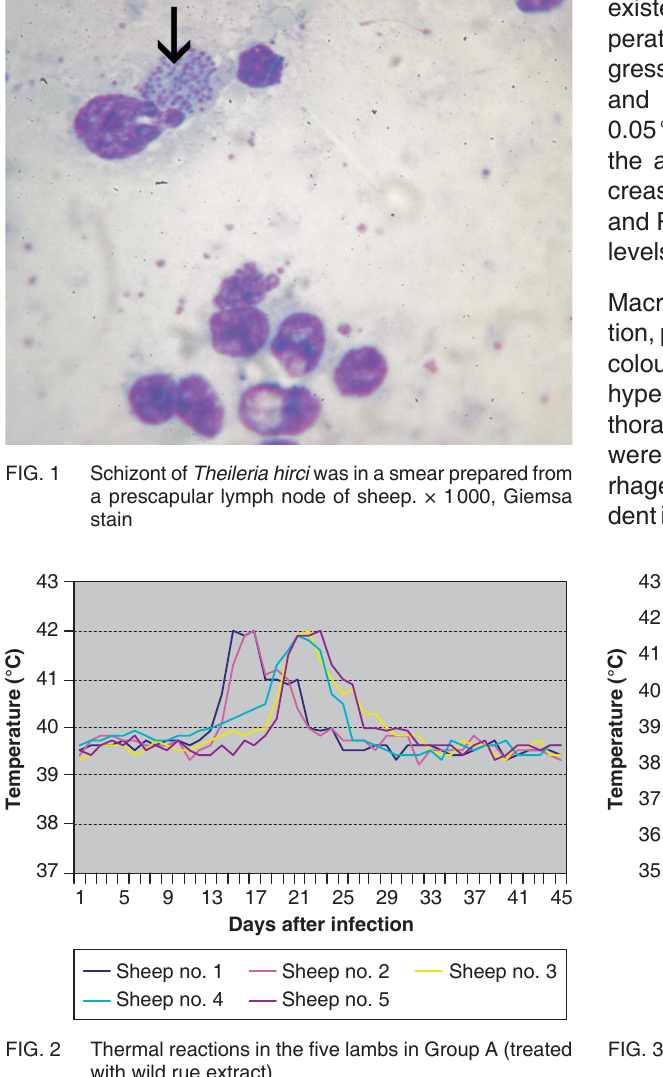
FIG. 2 Thermal reactions in the five lambs in Group A (treated with wild rue extract)